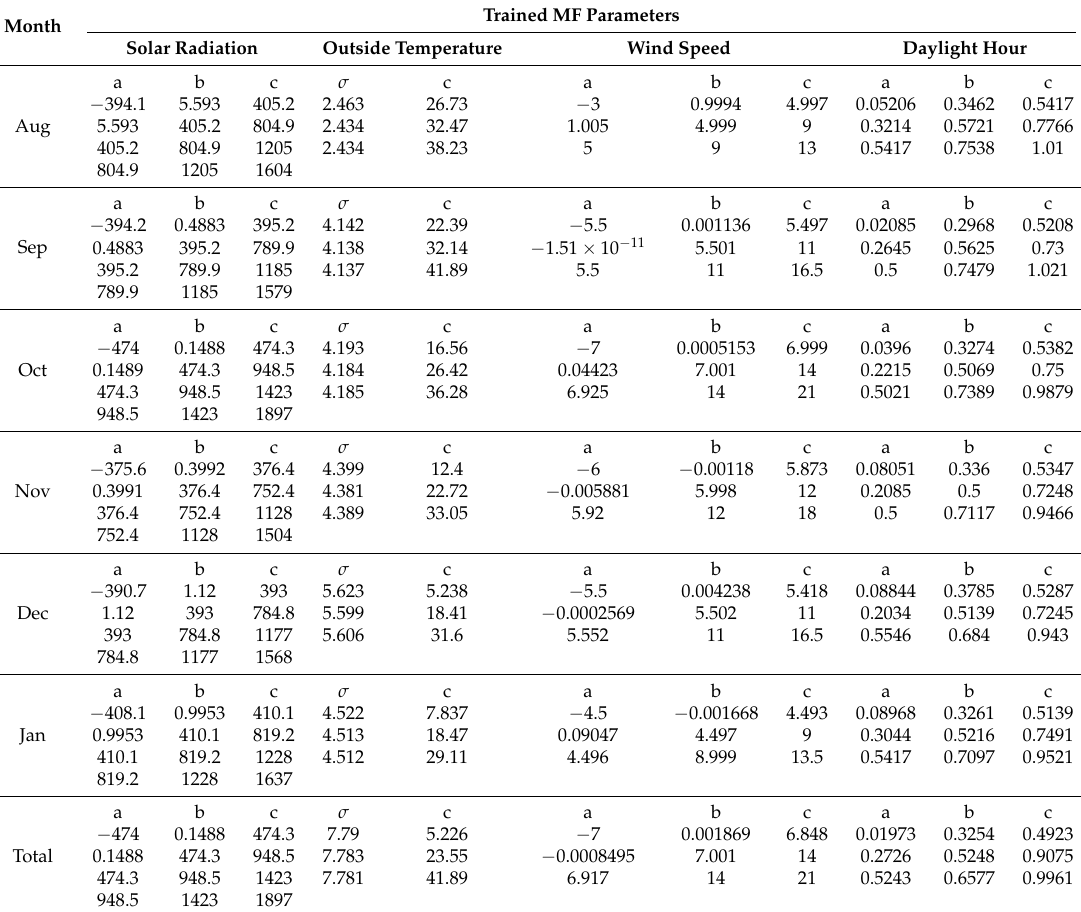
Table 2. Monthly and overall trained membership function (MF) parameters for